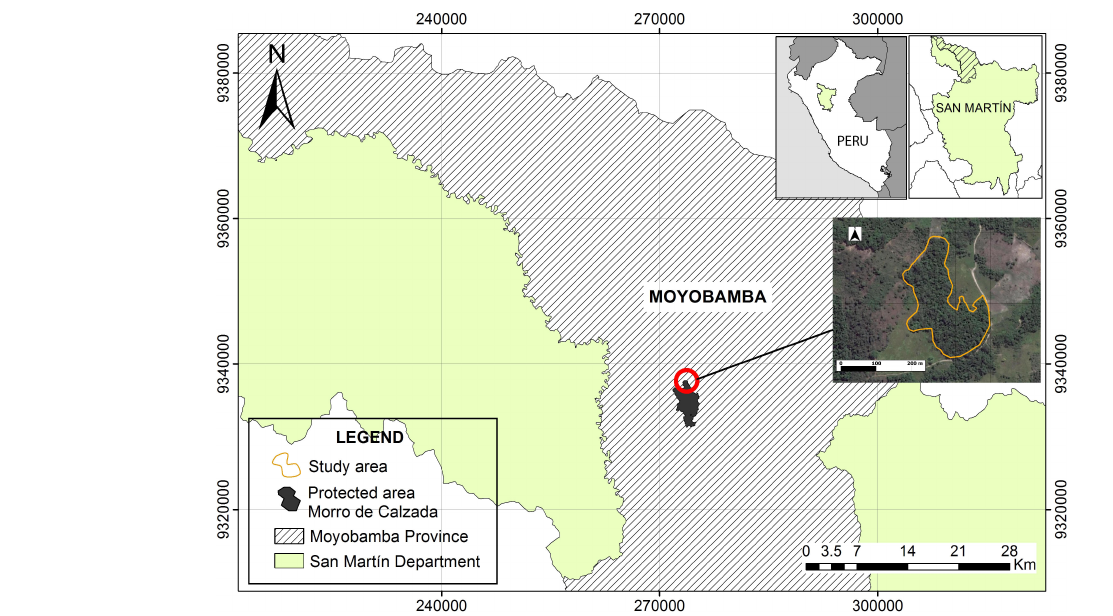
Figure 1. Location of the study area.